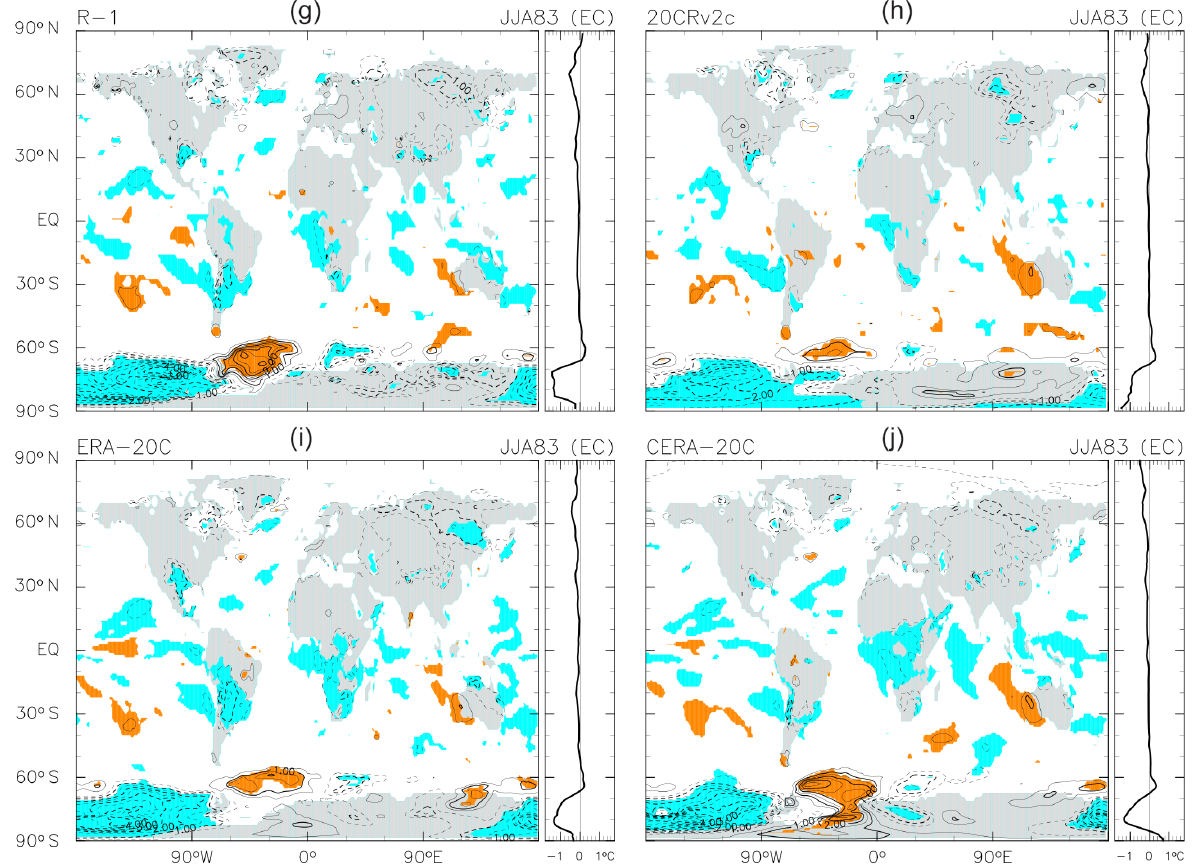
Figure 4. As for Fig. 2, but for the anomalies averaged over June to August 1983 following the El Chichón eruption in April 1982. The contour interval is 0.5K, without 0.0K lines. Coloured shading denotes anomalies that are positive (orange) or negative (blue) with magnitudes exceeding 1 SD of the 3-month mean R(t) at that